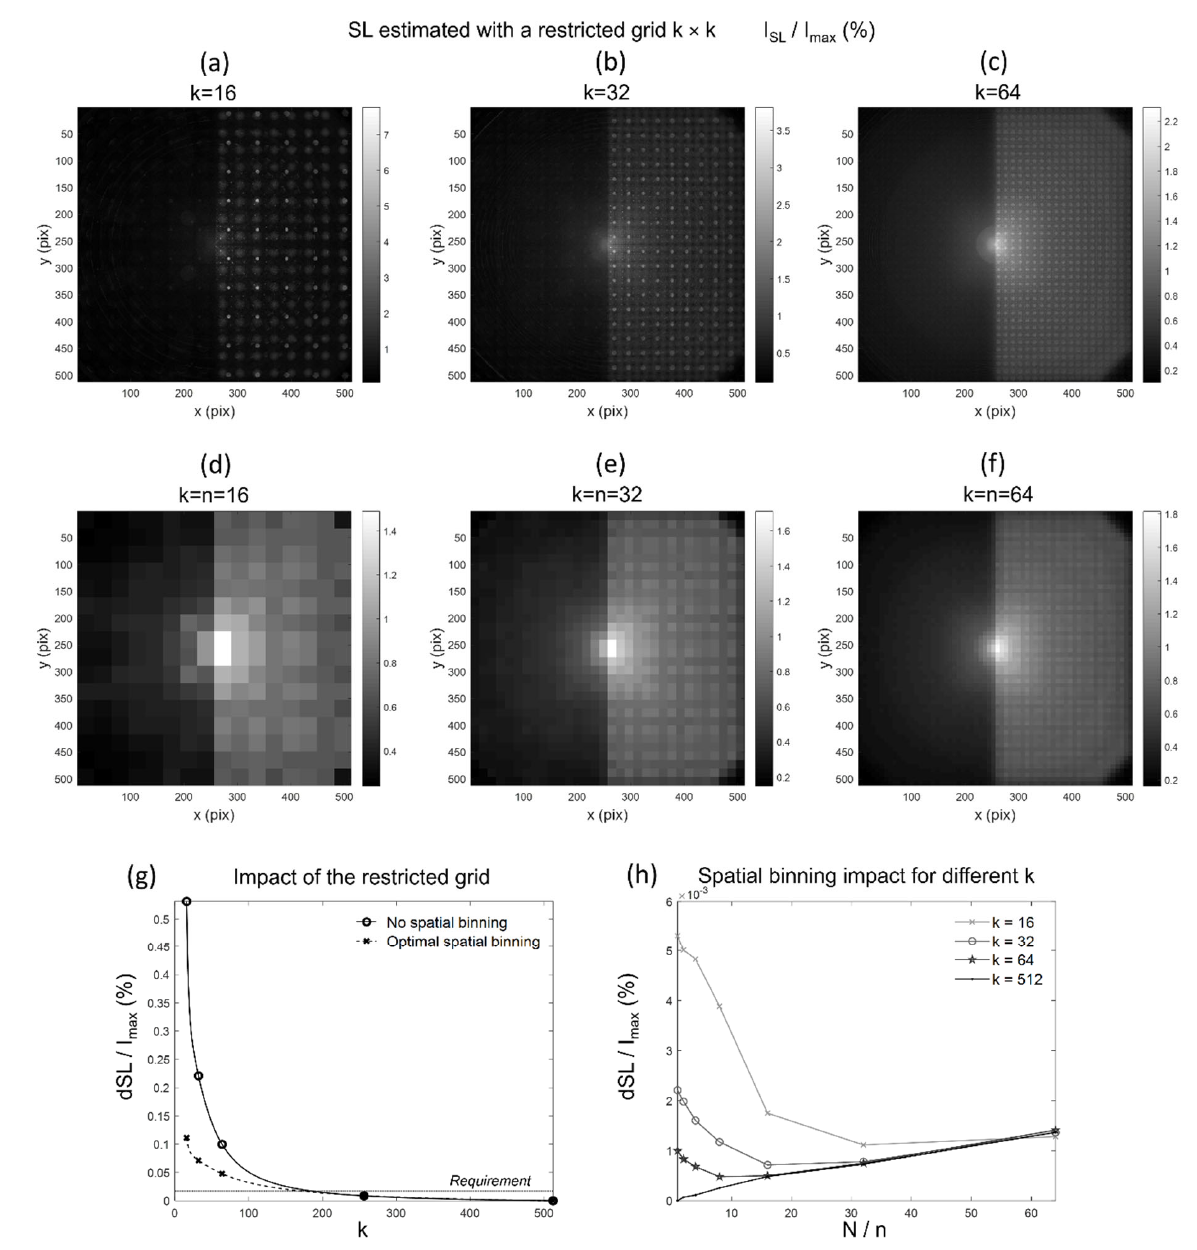
Figure 7. SL of the B and W extended scene, estimated with SPST maps known on a restricted grid k × k ( a – c ). The SL estimation can be improved by applying an optimal spatial binning ( d – f ). ( g ) SL estimation error dSL as a function of the grid size k , with or without the optimal spatial binning. ( h ) Error dSL as a function of the spatial binning n for different values of k . For each k , there is an optimal value of n minimizing the error.